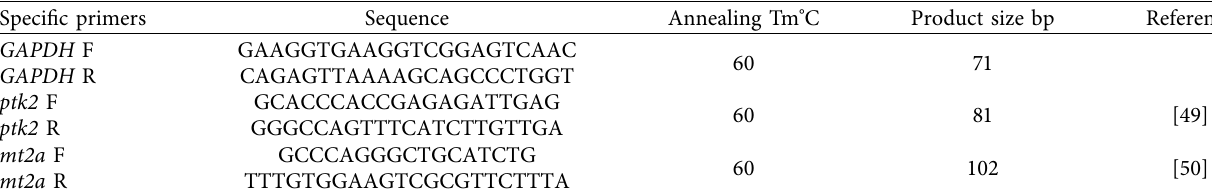
Table 3: Specific Primers of ptk2 and mt2a in Real-Time RT